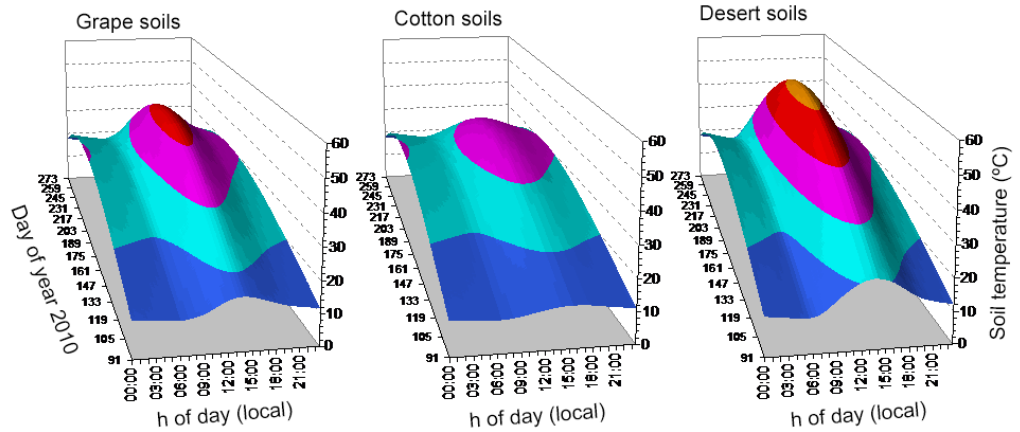
Figure 6. Seasonal variation in the diel soil temperature (30min resolution) for grape soils, cotton soils, and desert soils of the Tohsun Oasis for the entire growing period of 2010 (1 April (DOY 90)–30 September (DOY 273)).